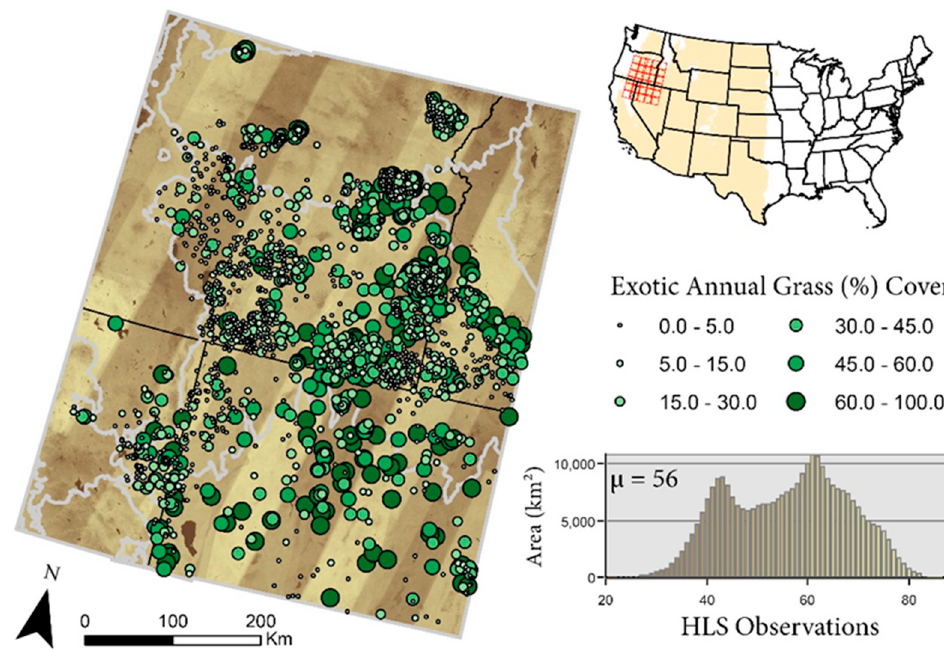
Figure 1. Number of valid harmonized Landsat and Sentinel-2 (HLS) observations from 2016 to 2018 overlaid by level III ecoregions [28] and Bureau of Land Management Assessment, Inventory, and Monitoring (AIM) plots (2016–2017). Black lines indicate state boundaries and inset shows Sentinel-2 tiles and drylands in the United States. Drylands are defined by an aridity index [29], where the average ratio of annual precipitation to potential evapotranspiration (1970 to 2000) is between 0.03 and 0.5.